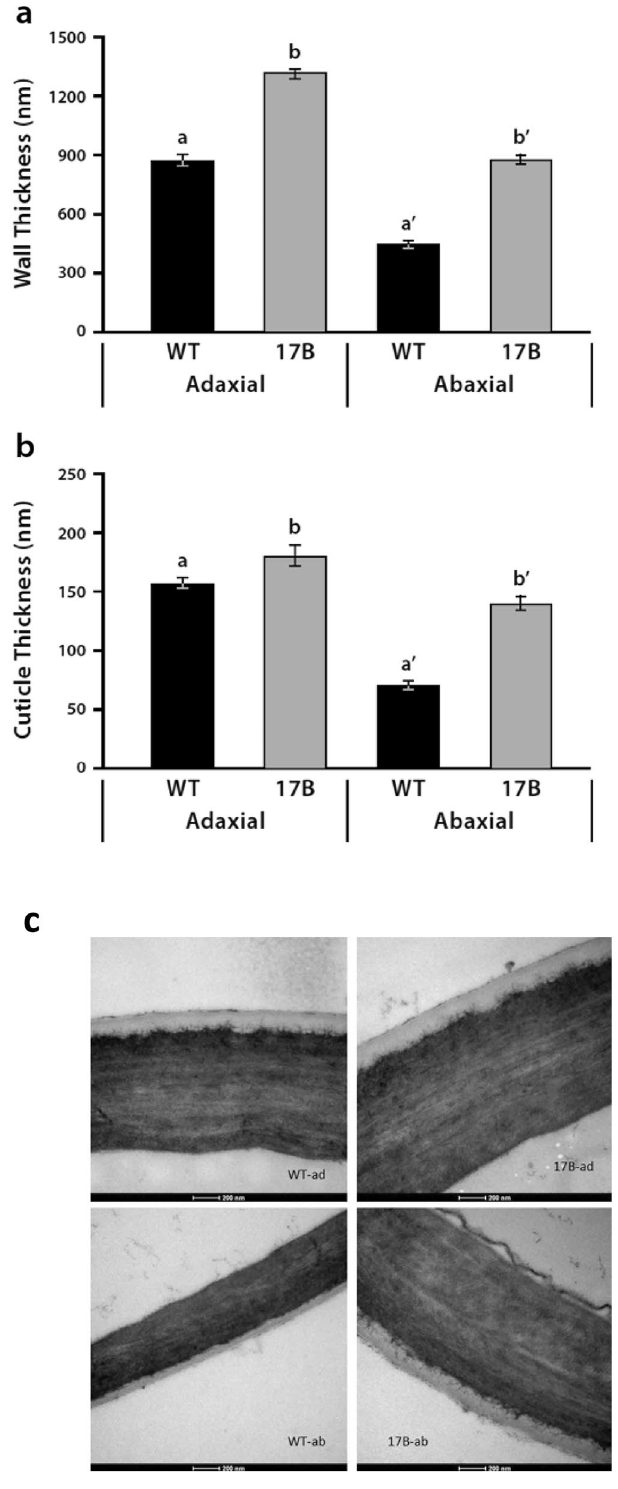
Figure 7. Leaves from the 17B transgenic soybean line displays a significant increase in cuticle and wall thickness of epidermal cells compared to wild-type (WT). Analyses of transmission electron microscopy (TEM) images of WT and 17B leaves show ( a ) an increase in the adaxial and abaxial thickness of the 17B epidermal cell walls compared to WT (adaxial p < 0.001, abaxial p < 0.001) and ( b ), increase in adaxial and abaxial cuticle thickness of 17B epidermal cells compared to WT (adaxial p < 0.05, abaxial p < 0.001). Data represent means ± SE, based on the Student’s t -test. Representative TEM images ( c ) of adaxial and abaxial epidermal cells from WT and 17B